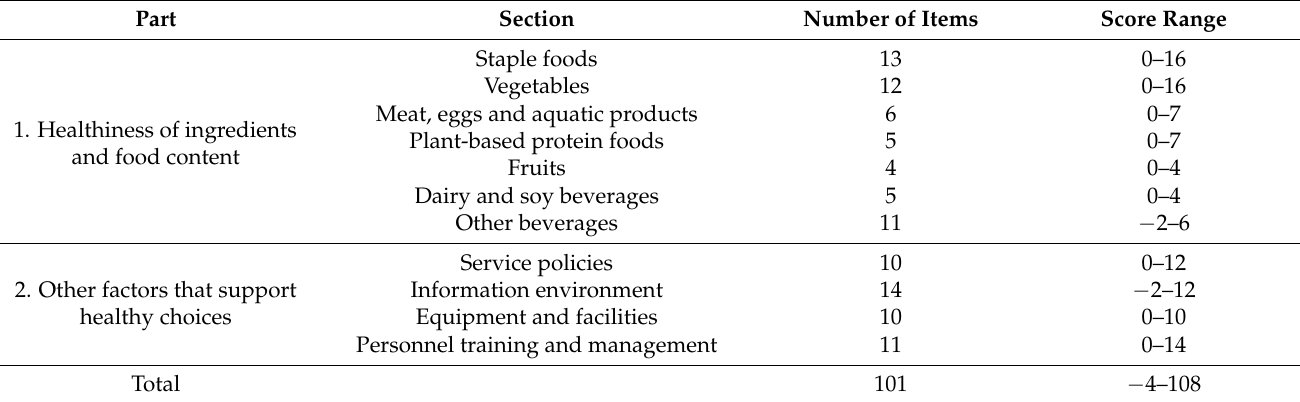
Table 1. Structure of Nutrition Environment Scoring for Chinese Style University/Work-site Canteens